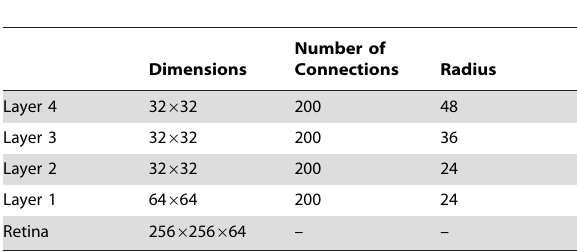
Table 5. Scaled up retina: Network dimensions.